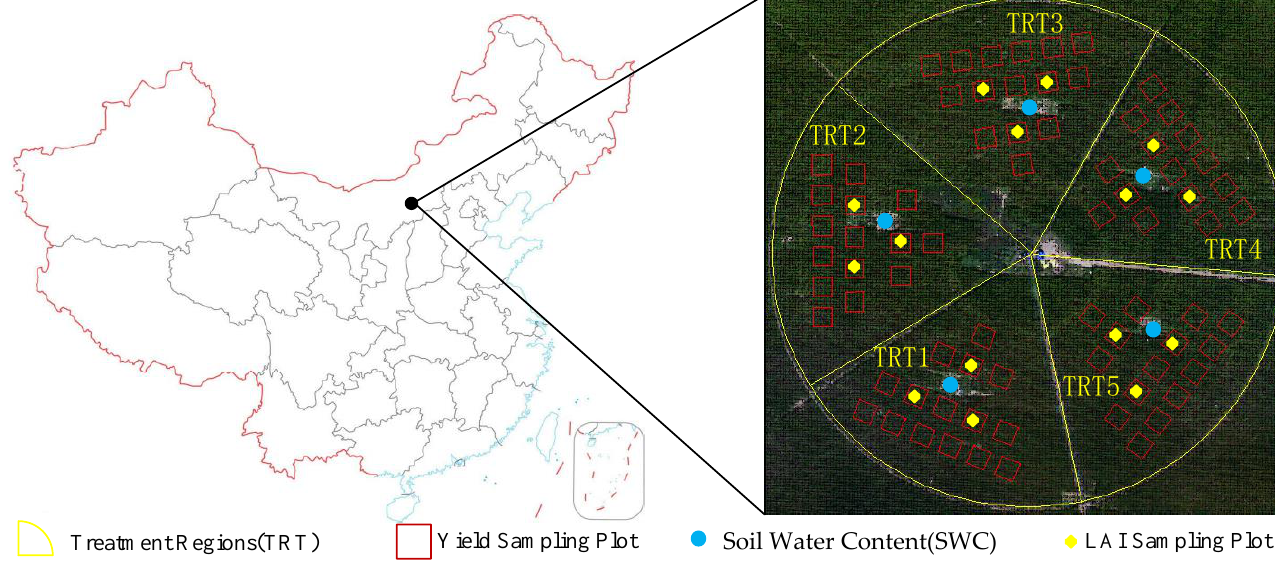
Figure 1. Aerial view of the experimental field indicating treatment region division and the location of sampling plots.